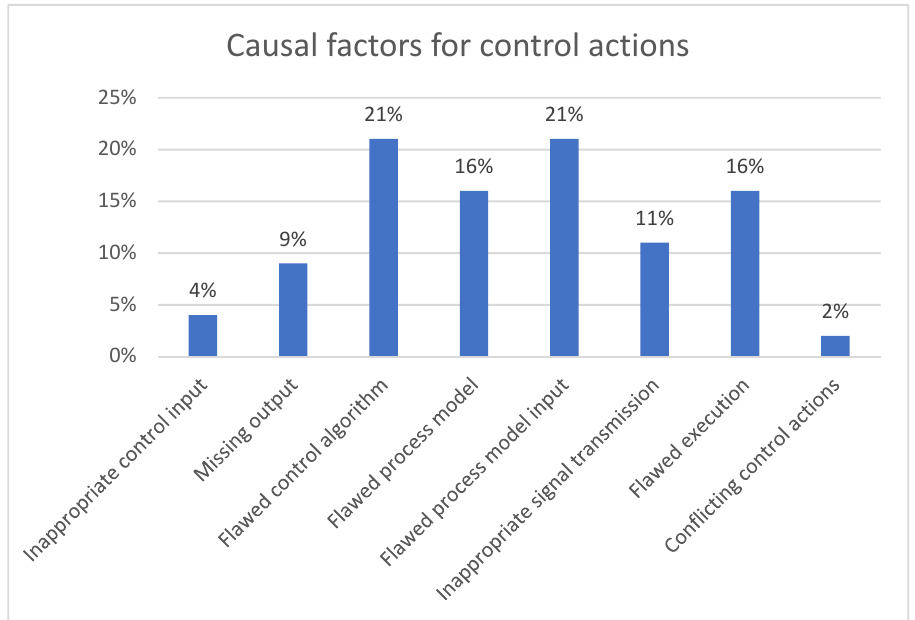
Figure 5. Distribution of causal factors.